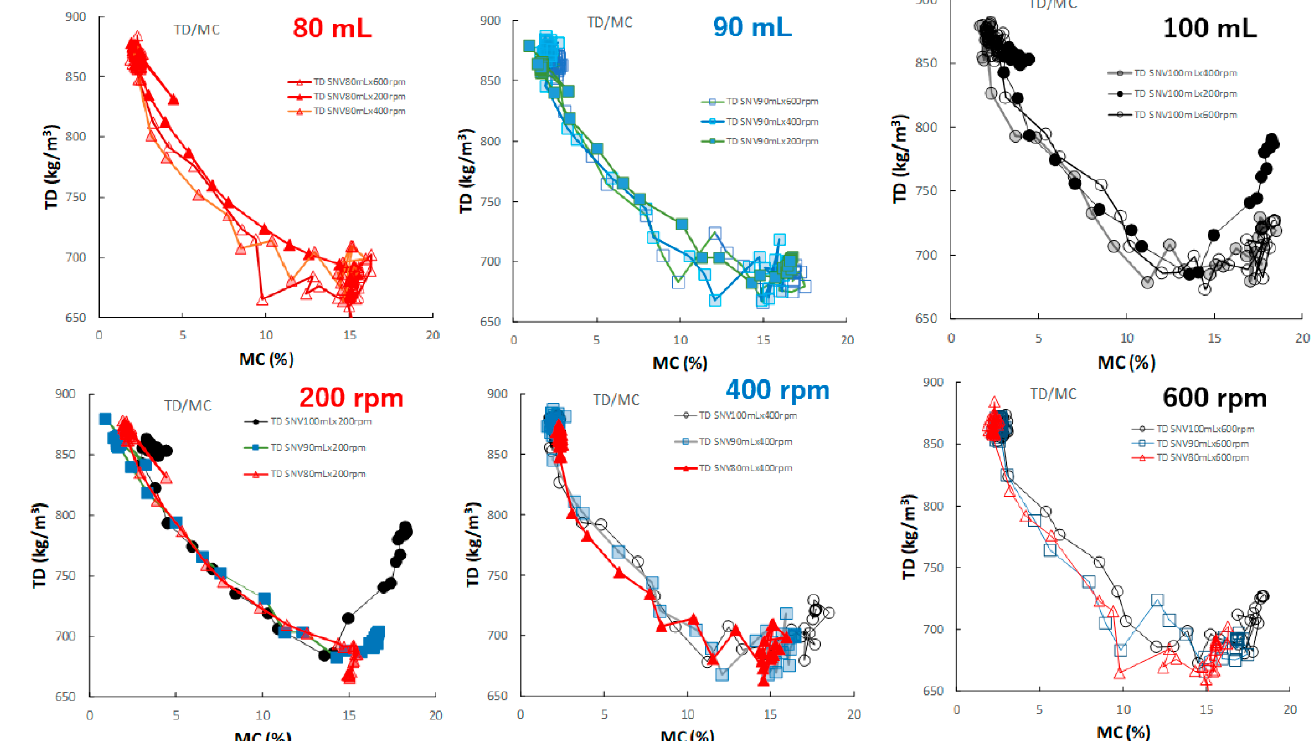
Figure 12. The effect of adding water and increasing stirring speed on the relationship between TD and MC of the HSWG granules.